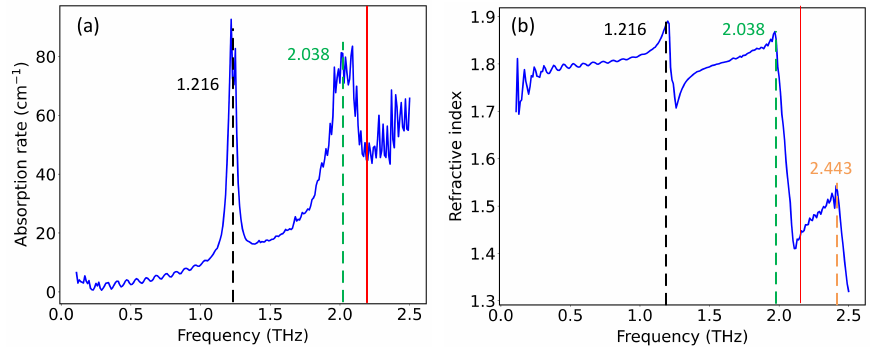
Figure 3. ( a ) The absorption rate of the D-Glutamic acid. ( b ) The refractive index of the D-Glutamic acid. Absorption peaks located at 1.216, 2.038, and 2.443 THz are highlighted by dashed black, green, and orange lines, respectively. The solid red line located at 2.2 THz marks the frequency, after which the absorption rate is no longer in accordance with the actual spectrum. Nevertheless, the refractive index holds with the actual trend after 2.2